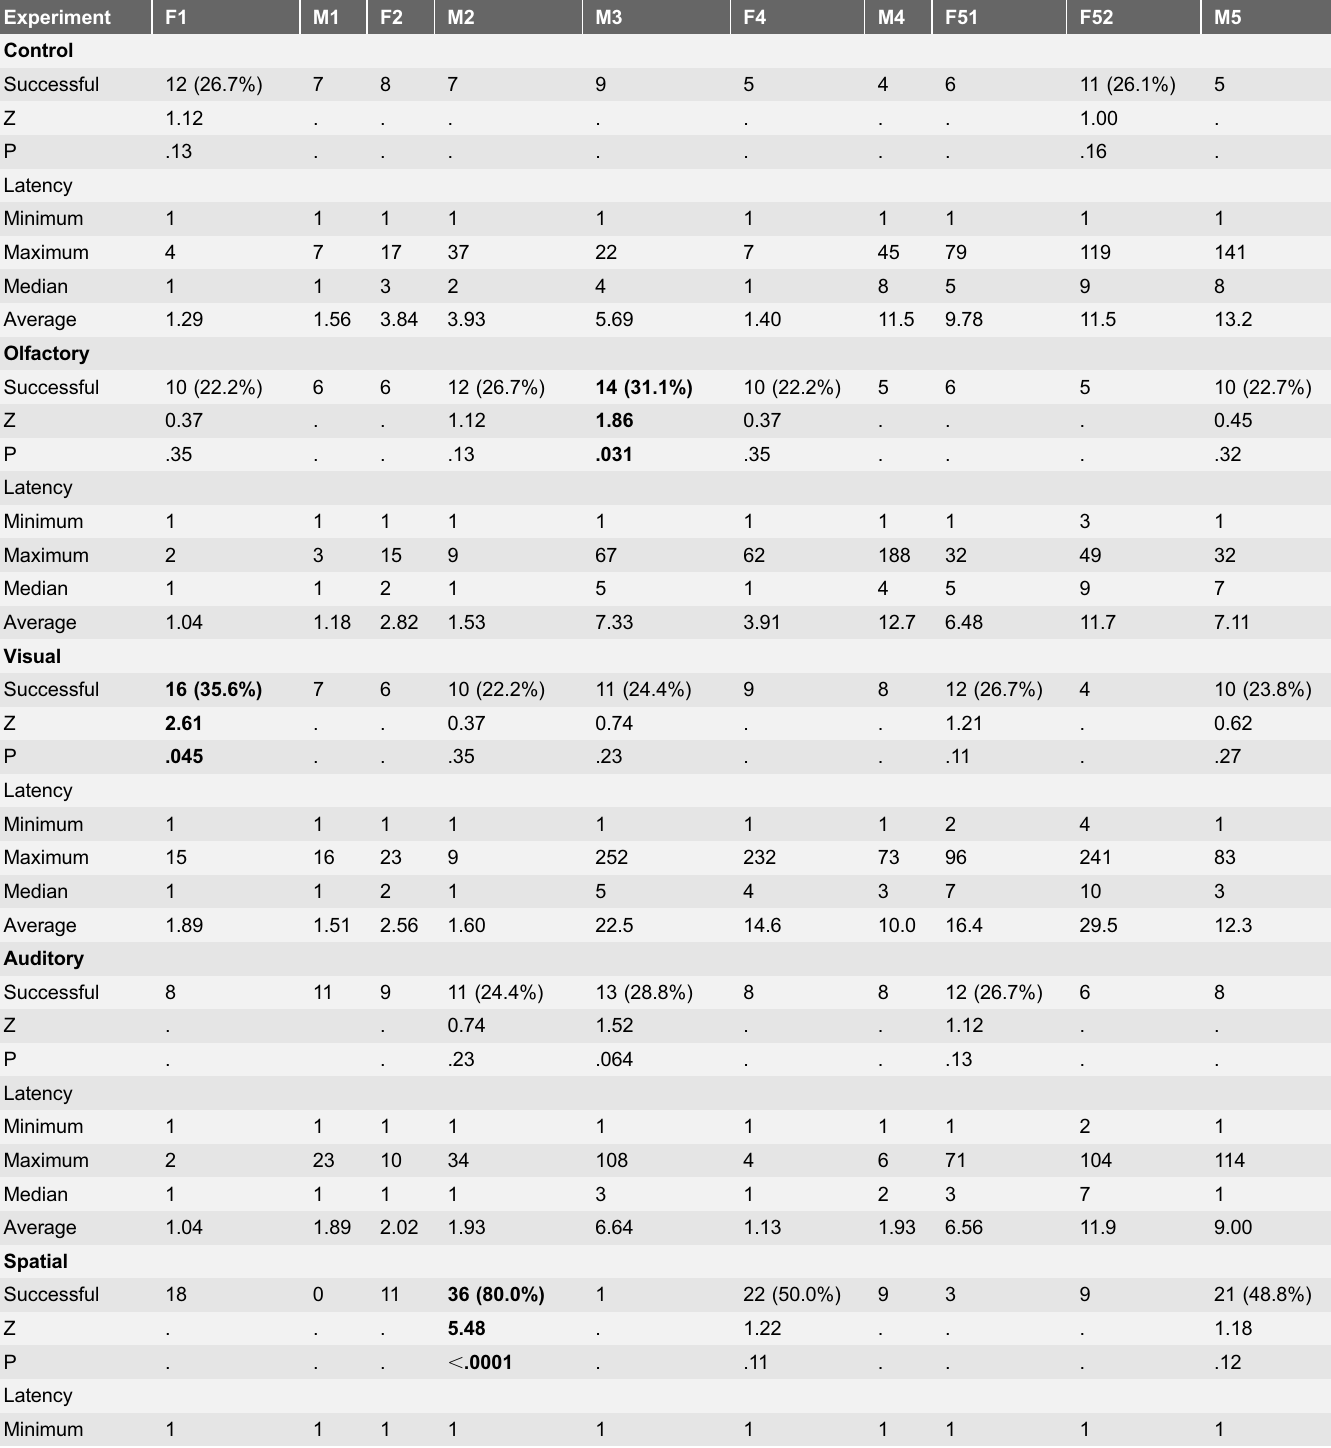
Table 2. Individuals’ performance on the first choice of each session during each experiment showing the amount of successful choices (and their respective %), result of the binomial test (Z and P) for the values . 9 (all experiments, except the spatial + quantitative) and . 18 (spatial + quantitative experiment) and average, median, minimum and maximum latency (in seconds) between the start of each session and the inspection of the first